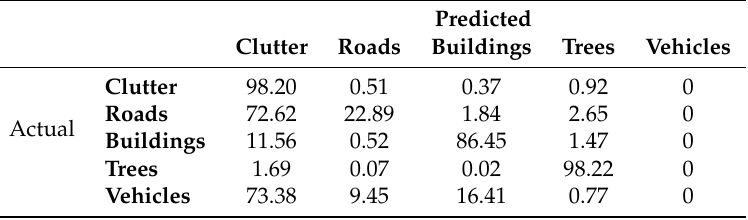
Table A9. Normalized confusion matrix for the CNN model that is trained on color.